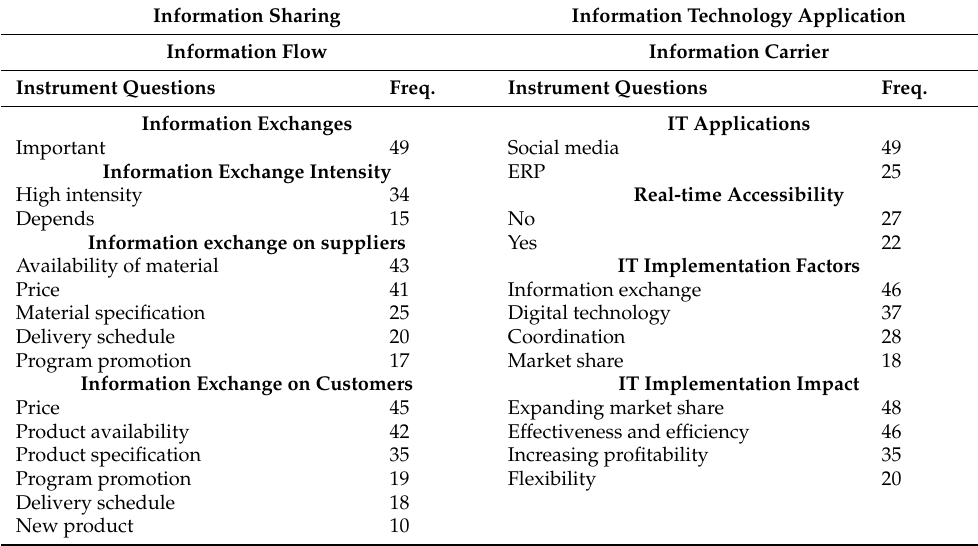
Table 6. Data collected from correspondents based on the information exchange